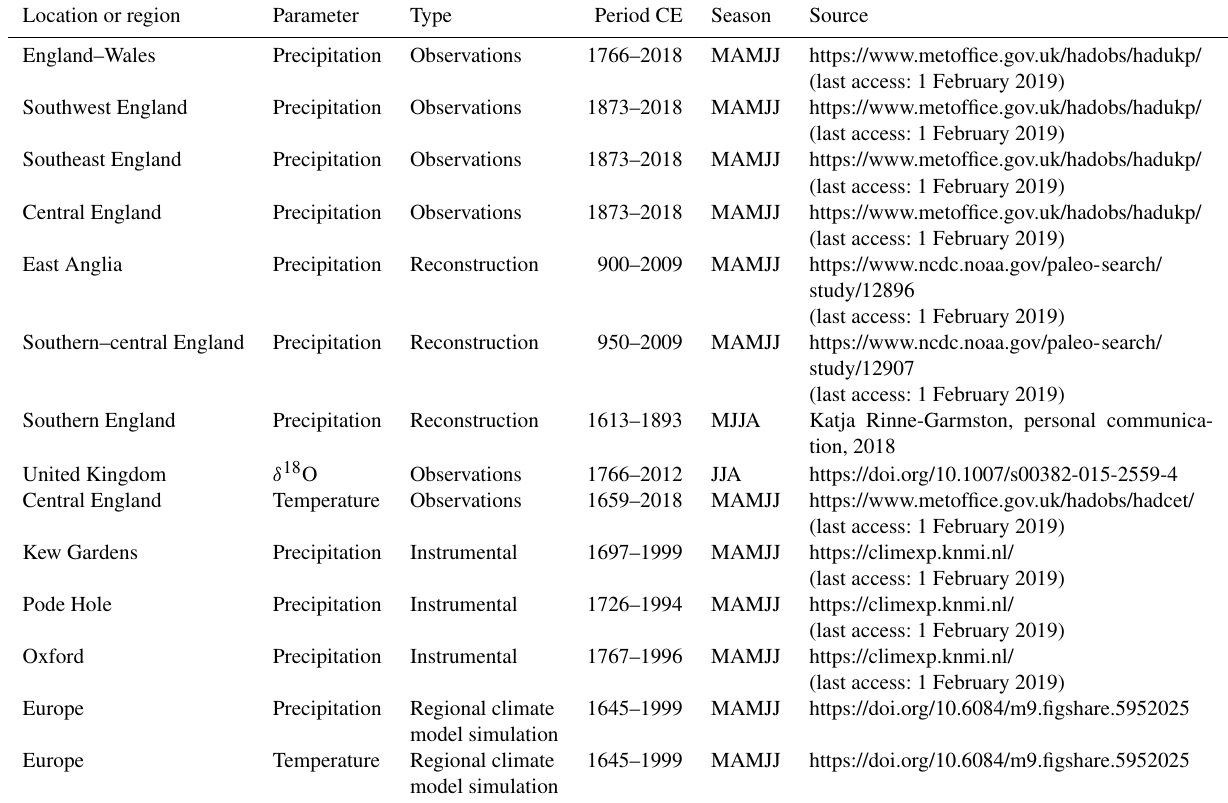
Table 1. List of data sets by region, parameter, type of data, period covered, season used, and source for obtaining the data. Location or